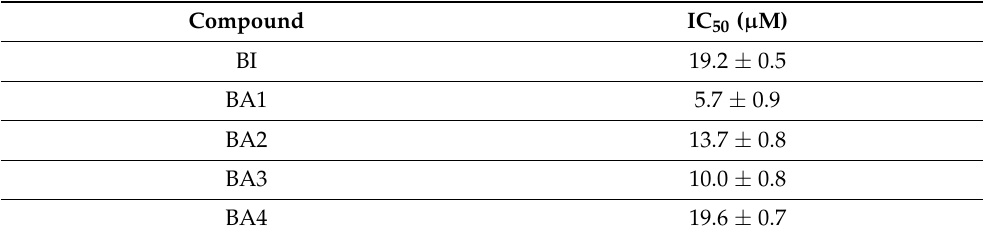
Figure 2. Viability of A375 human melanoma cells following 72 h stimulation with BI, BA1, BA2, BA3, and BA4 at concentrations of 1, 10, 25, 50, and 75 µM. The study results are reported as a percentage (%) of cell viability in comparison to the control cells. One-way ANOVA followed by Dunnett’s multiple comparison post-test was used to compare the groups. A p -value ≤ 0.05 was regarded as statistically significant (**** p ≤ 0.0001 vs. control). Table 1. IC 50 (µM) values yielded from the MTT assay. A375 melanoma cells were incubated with betulinic acid and 2,3-indolo-betulinic acid derivatives for 72 h. The data are presented as the mean ±SD of three replicated assessments.